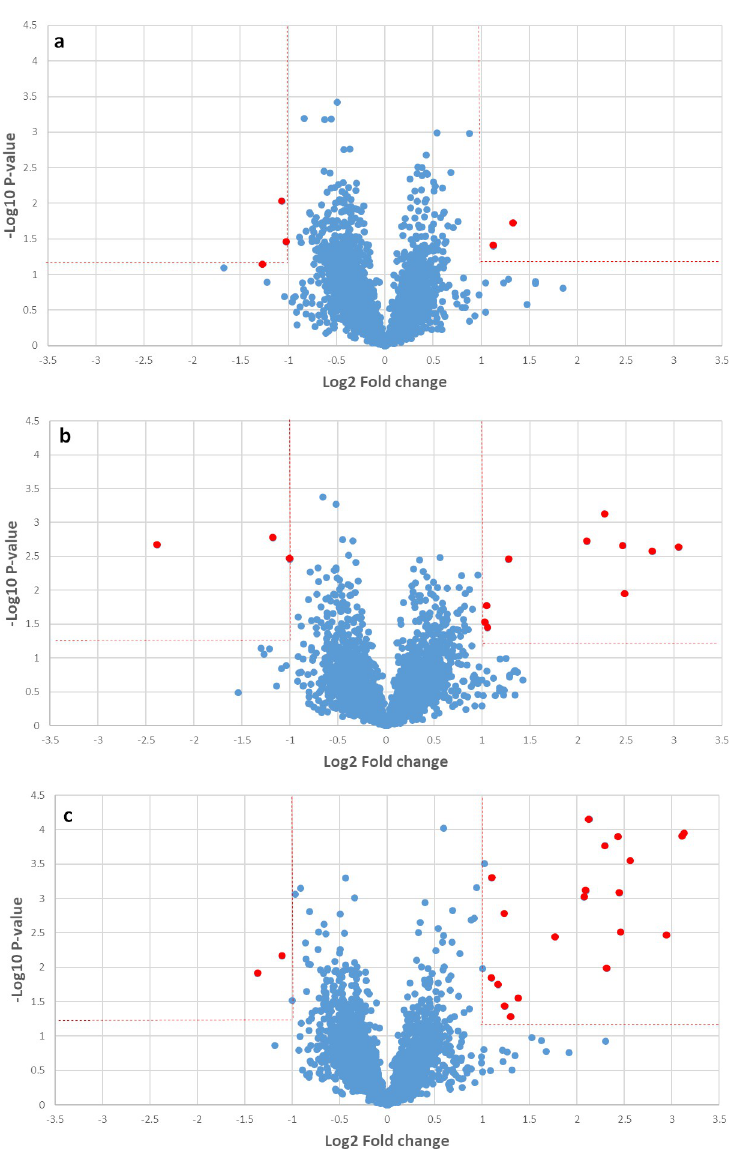
Fig 2. Volcano plots comparing the expression of mouse proteins (blue dots) in mouse sera infected with T . spiralis 2 (a), 4 (b) and 8 weeks (c) post infection with those in uninfected sera. Statistically significant differential expression of proteins (red dots) is defined as a minimum 2-fold change relative to the uninfected condition (level of magnitude, vertical lines) and p < 0.05 (level of statistical significance, horizontal line). T01_4395 (KRY33215.1) and putative protein tag-76 (KRY38162.1) were discovered with the highest confidence 4 weeks after infection. Eight weeks post infection, T . spiralis muscle M- line assembly protein unc-89, intron-binding protein aquarius (KRY36956.1) and WD repeat- containing protein 44 (KRY28737.1) were found in the infected mouse sera with the highest confidence. The SignalP and SecretomeP servers predicted that 11 out of 33 proteins were pos- sible secretory proteins, such as acetylcholine receptor subunit alpha-like 1, long-chain fatty acid transport protein 1 and peroxidasin-like protein. Interestingly, peroxidasin-like protein was observed at all three post-infection time points (Table 2). In addition, four T . spiralis